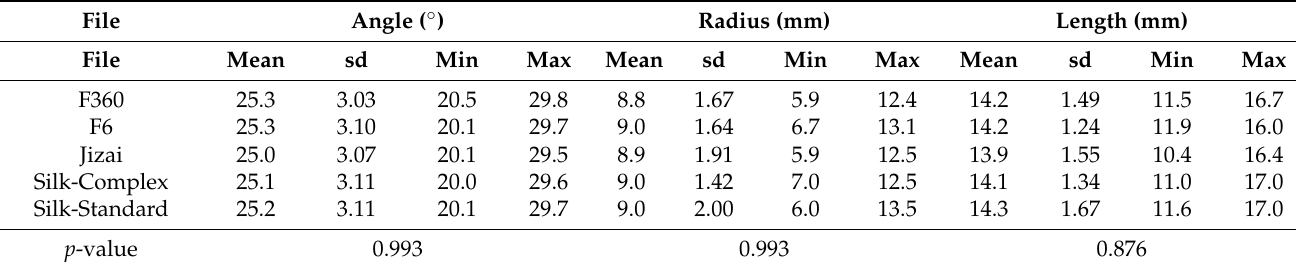
Table 1. Parameters of the included curved root canals ( n = 20 teeth per group; length = distance between apex to cemento-enamel junction; sd = standard